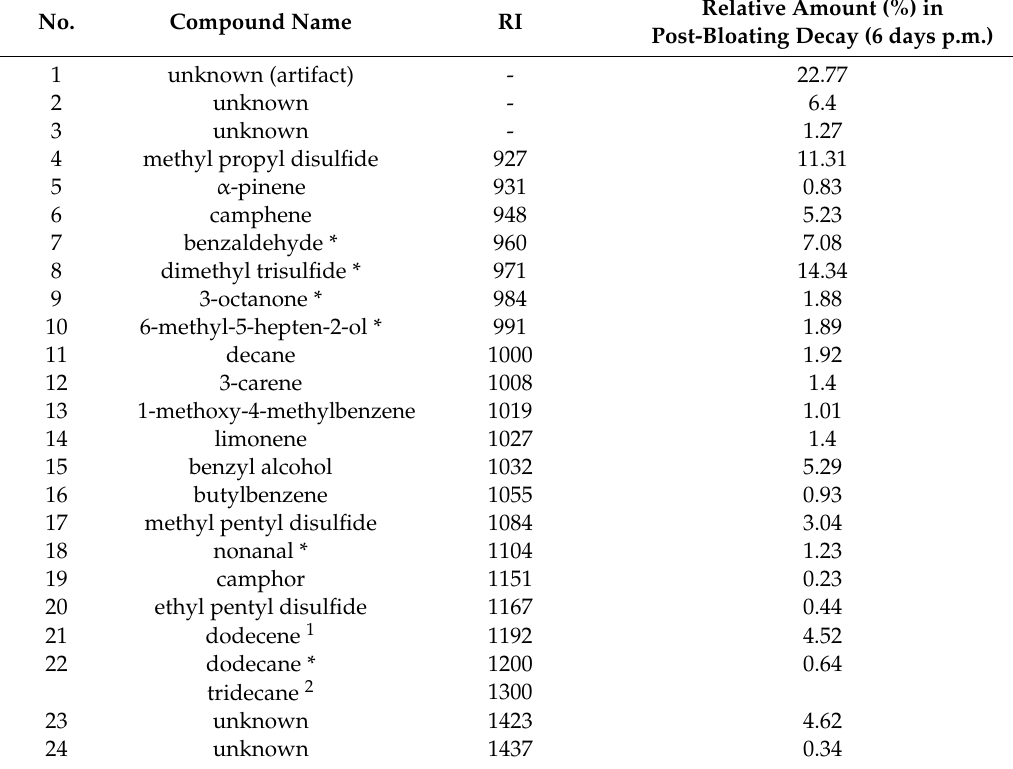
Table 1. Relative amounts (in%) of all GC–EAD active compounds perceived by Anoplotrupes stercorosus in the pooled headspace sample of piglets in post-bloating decay (6 days post